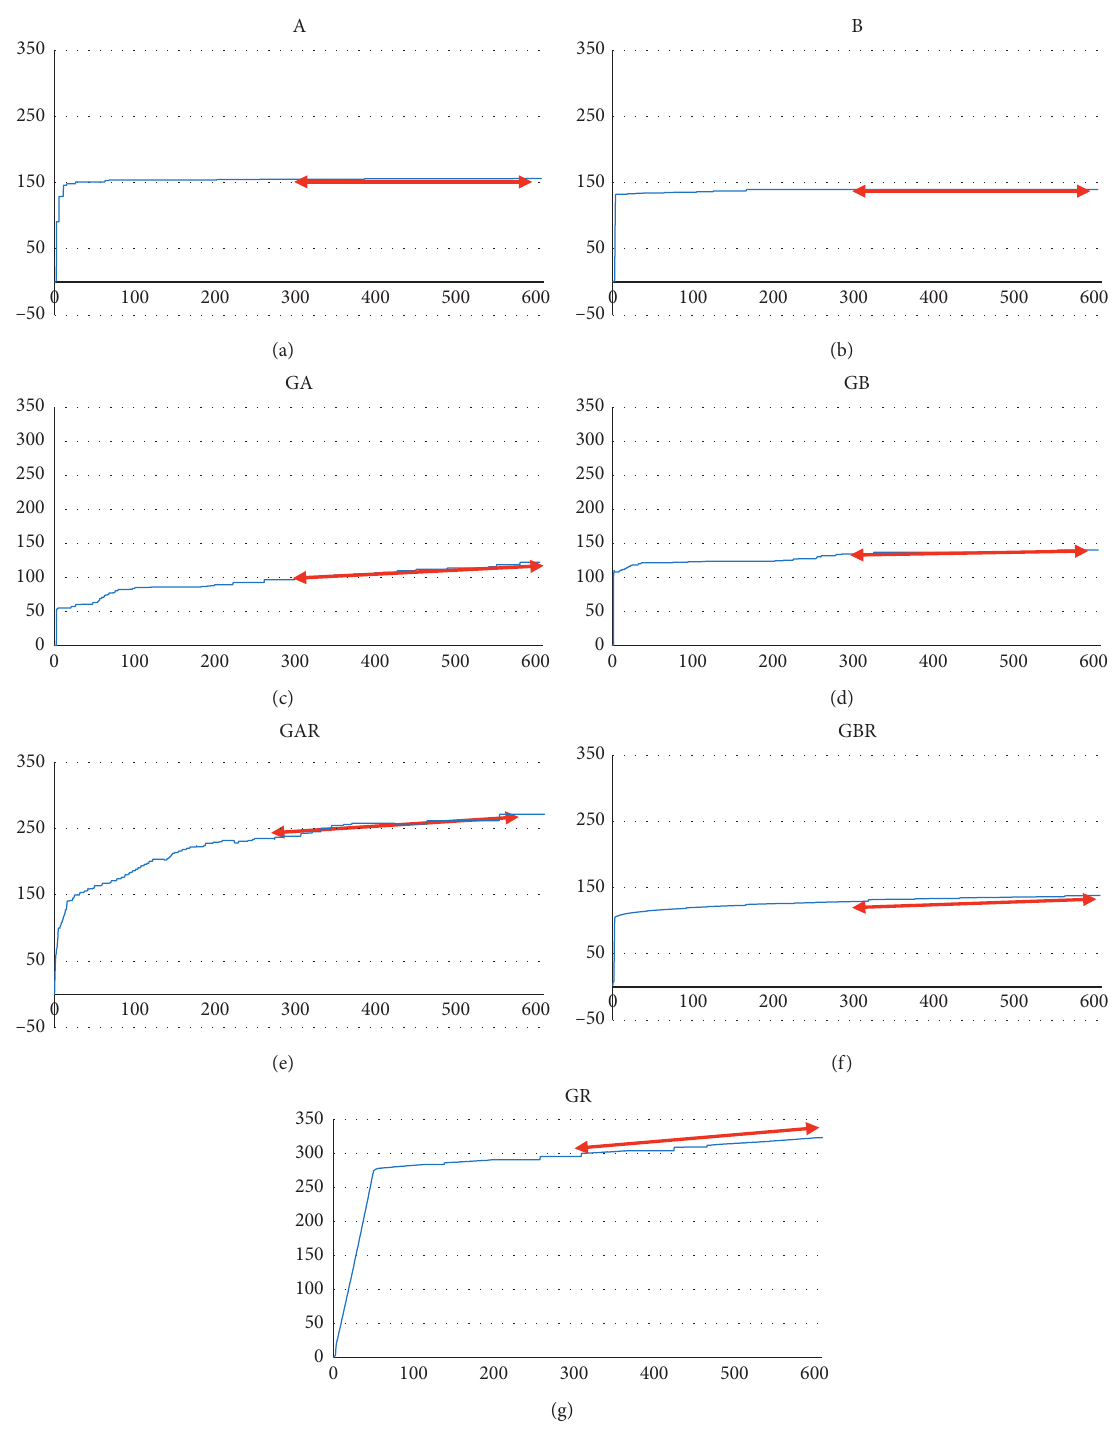
Figure 3: Representative graph of fluid flow (nL) in 600 seconds. Leakage was measured as the flow rate (slope of the graph) after flow stabilization (red arrows). A, AH Plus; B, GuttaFlow bioseal; GA, GP cone with AH Plus; GB, GP cone with GuttaFlow bioseal; GAR, root canal filling with GP cone and AH Plus; GBR, root canal filling with GP cone and GuttaFlow bioseal; and GR, root canal filling with GP cone without